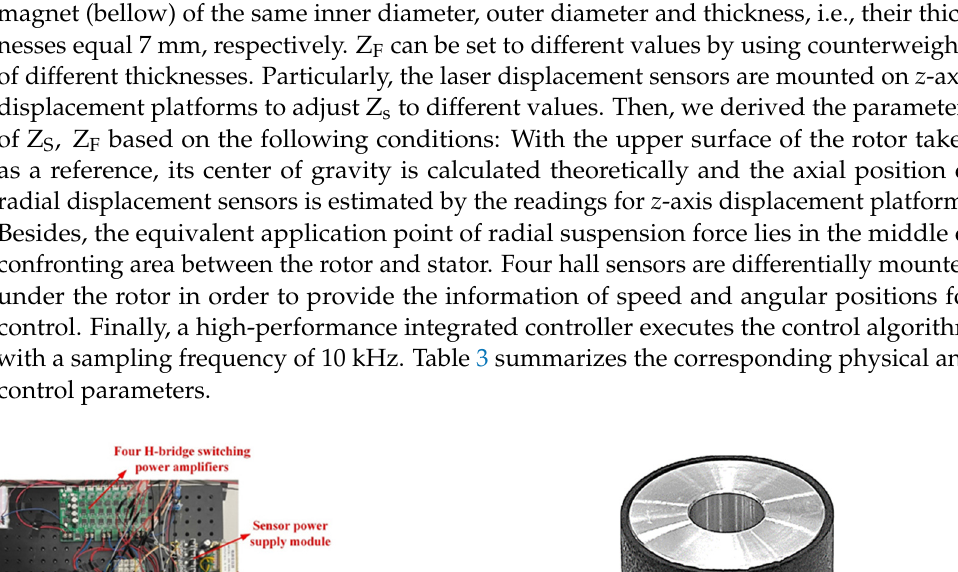
Table 3. System parameters relevant to the employed MLSM.